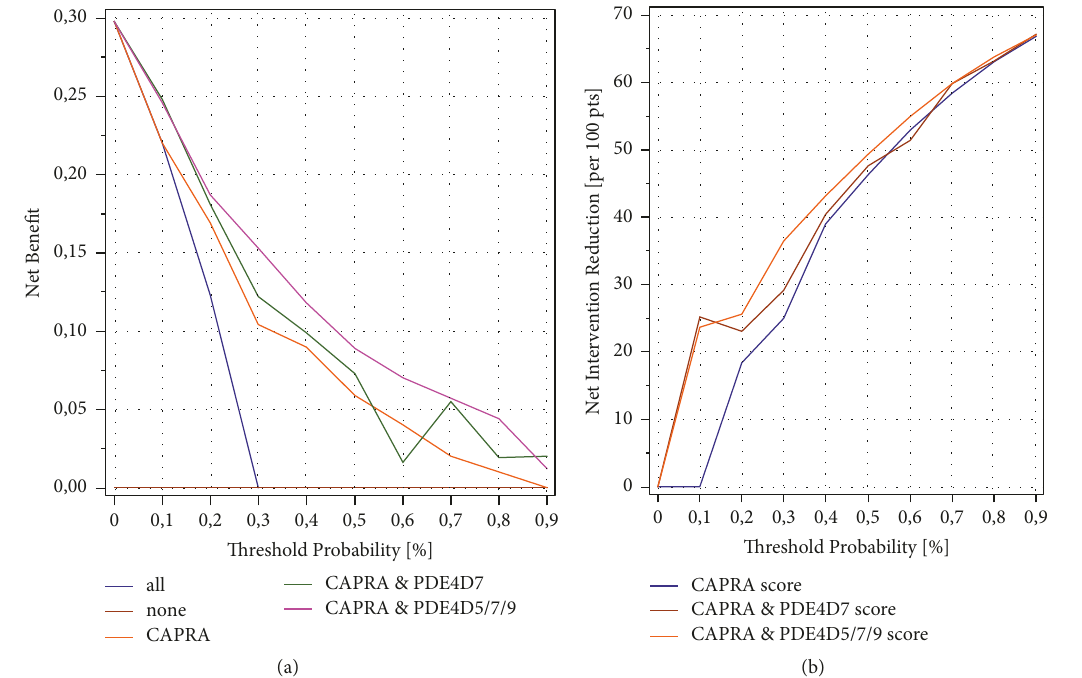
Figure 4: (a) Decision curve analysis in the diagnostic biopsy (DB) patient cohort of the net benefit of five different treatment decision strategies (treat all, treat none, treat based on the CAPRA score, treat based on the CAPRA and PDE4D7 score, treat based on the CAPRA and PDE4D5/7/9 score) for men at risk of disease recurrence within 5 years after surgery. In total 45 of the 151 investigated patients failed the initial primary treatment of surgery by PSA recurrence (29.8%) within 5 years after intervention. Treatment strategies were tested for their net benefit across indicated threshold probabilities (0.05 step size) to trigger prostate surgery based on the probability of future disease recurrence. The CAPRA scores, the CAPRA and PDE4D7 scores, and the CAPRA and PDE4D5/7/9 scores were converted into 5-year BCR probabilities with logistic regression on the BP cohort (n=151 men with completed 5-year follow-up) before estimating net benefit. (b) Net reduction analyses demonstrating in how many patients a resection can be avoided based on the predicted risk of BCR derived from the CAPRA score and the CAPRA and PDE4D7 and CAPRA and PDE4D5/7/9 scores,